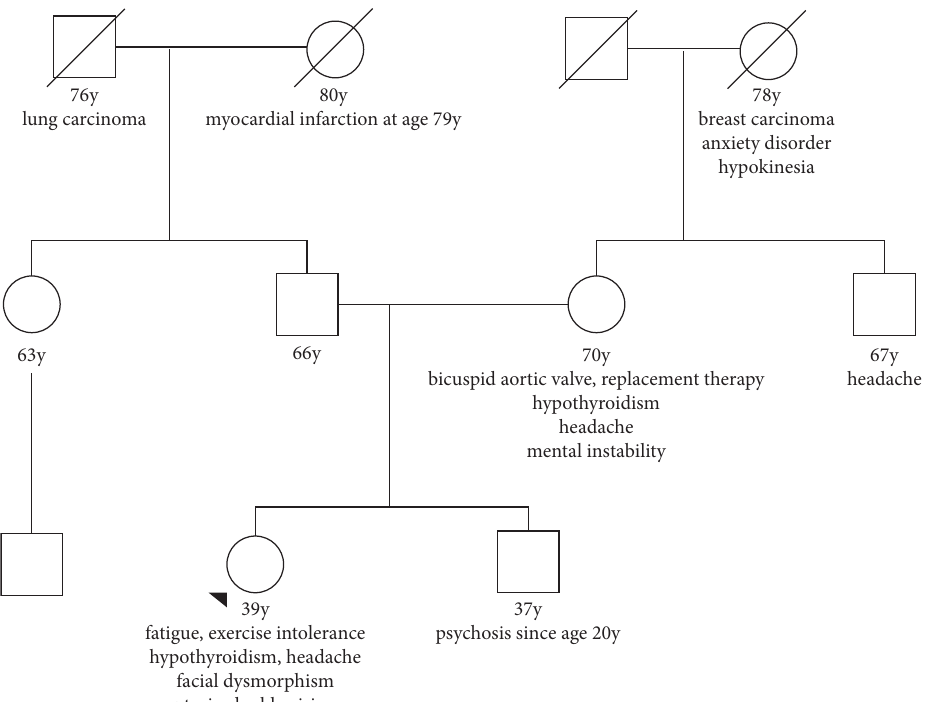
Figure 1: Pedigree of the index patient’s family revealing that a maternal trait of inheritance is quite likely despite absence of the culprit variant in the